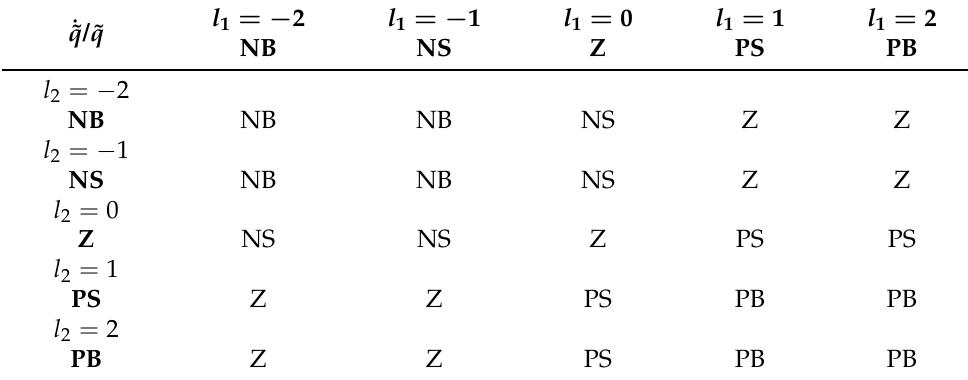
Table 1. Fuzzy rules look-up